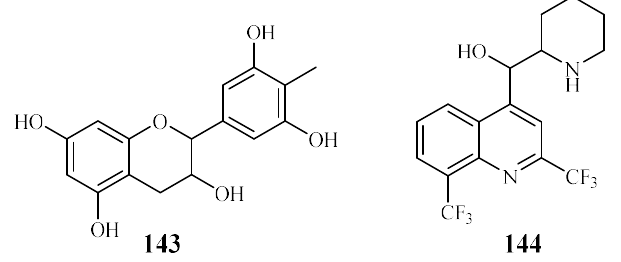
Figure 32. Compound from Theaceae plants.